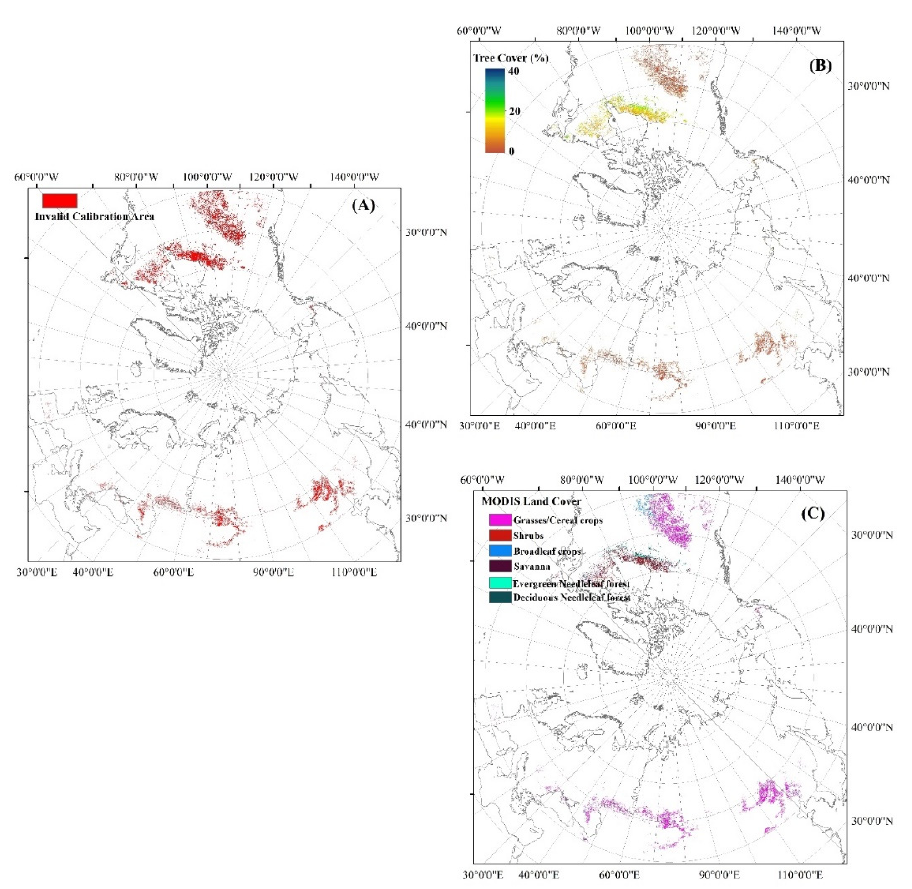
Figure 4. Spatial distributions of the invalid calibration areas ( A ), moderate-resolution imaging spectroradiometer (MODIS) tree cover ( B ), and MODIS land-cover types ( C ).